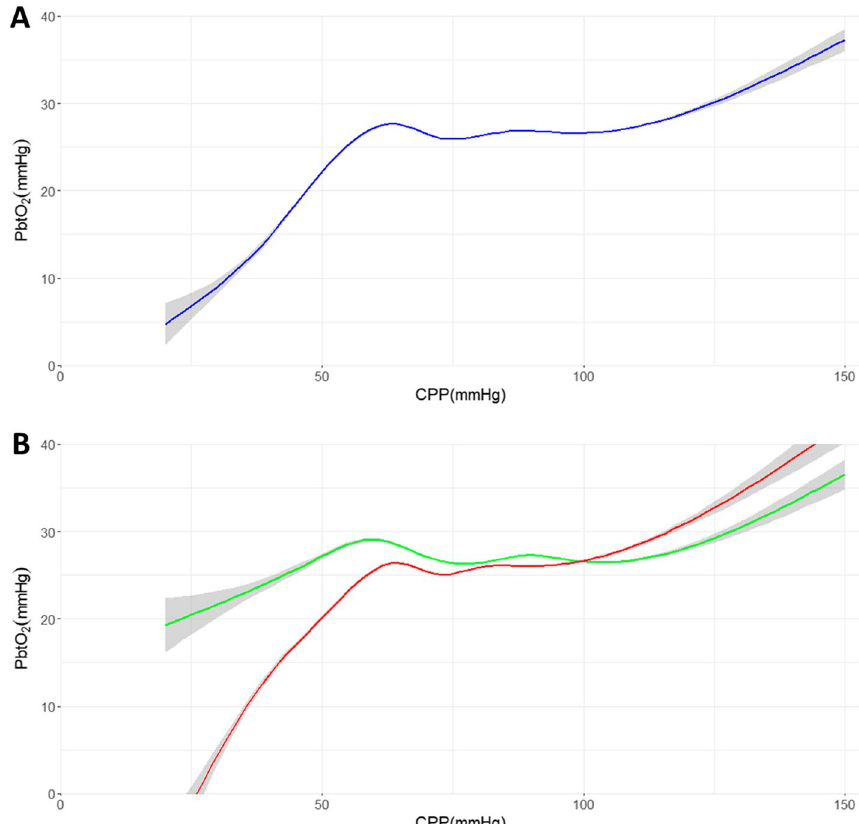
Fig. 1 The relationship of brain tissue oxygenation (PbtO 2 ) versus cerebral perfusion pressure (CPP) is seen in ( A ). In B , this relationship is examined when cerebrovascular pressure reactivity is intact (green) as compared to when it is disrupted (red). Note that 95% confidence intervals for all tracings are shown in